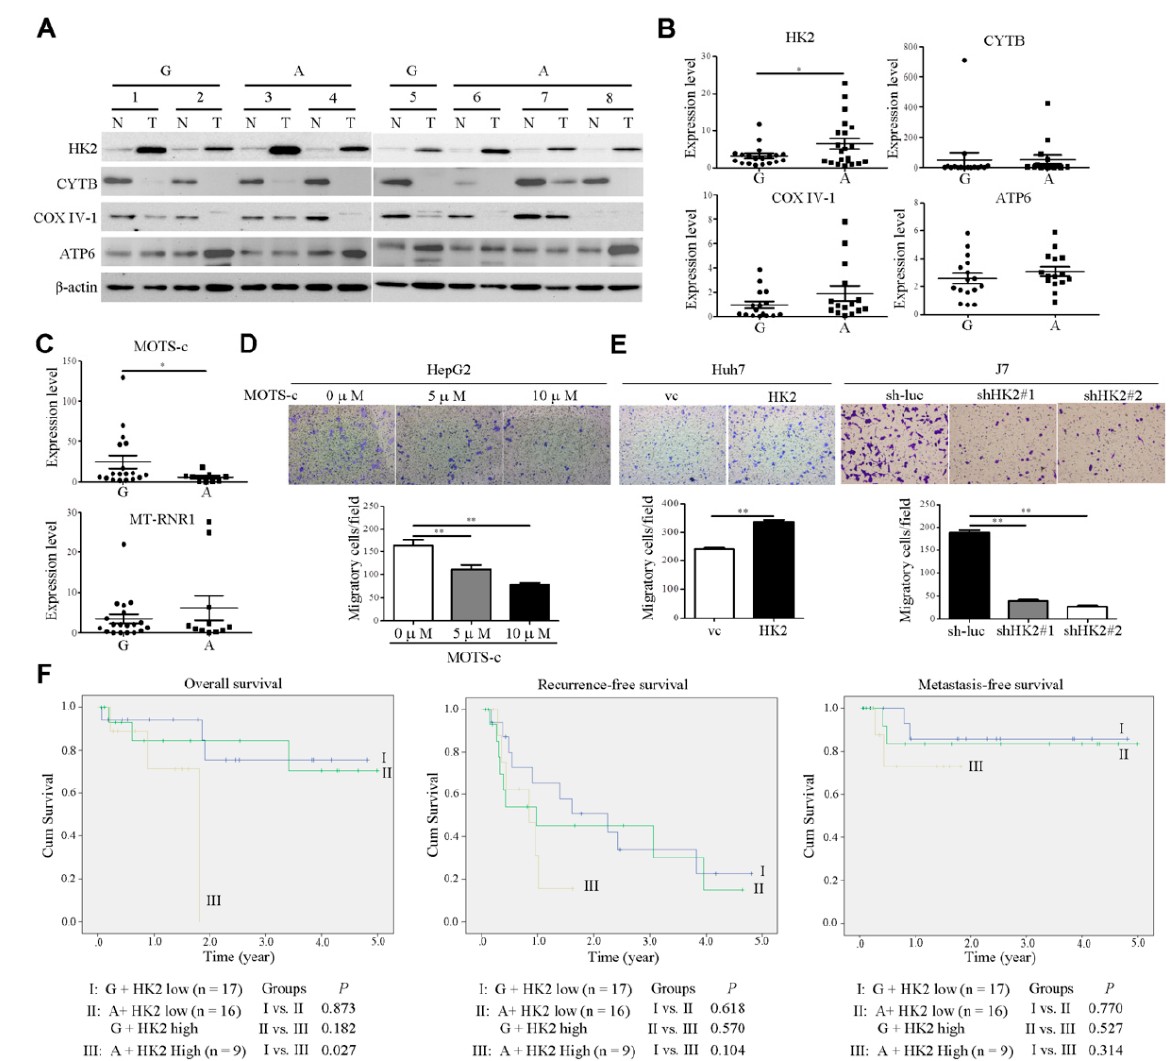
Figure 5. The MT-RNR1 709A/HK2 axis is correlated with poor prognosis in HCC patients. ( A , B ) Western blot analysis of HK2, CYTB, COXIV-1, and MT-ATP6 expression in paired HCC specimens. Protein expression was examined in eight representative pairs of HCC specimens, with β -actin as the loading control. The quantitative results of those genes were calculated and are shown in the MT-RNR1 709G and 709A groups. G: MT-RNR1 709G; A: MT-RNR1 709A. ( C ) Expression levels of MOTS-c and MT-RNR1 in HCC specimens were determined by qRT-PCR. 18S rRNA was used as a loading control. The transwell migration assay was performed in MOTS-c-treated cells ( D ) and HK2 stable cell lines ( E ). ( F ) Kaplan–Meier survival analysis curve of high- and low-risk survival groups in 43 paired HCC patients. MT-RNR1 709A and simultaneous high HK2 levels were significantly associated with the poorest overall survival. p -values were determined via the log-rank test. G: MT-RNR1 709G; A: MT-RNR1 709A. *, p < 0.05; **, p <